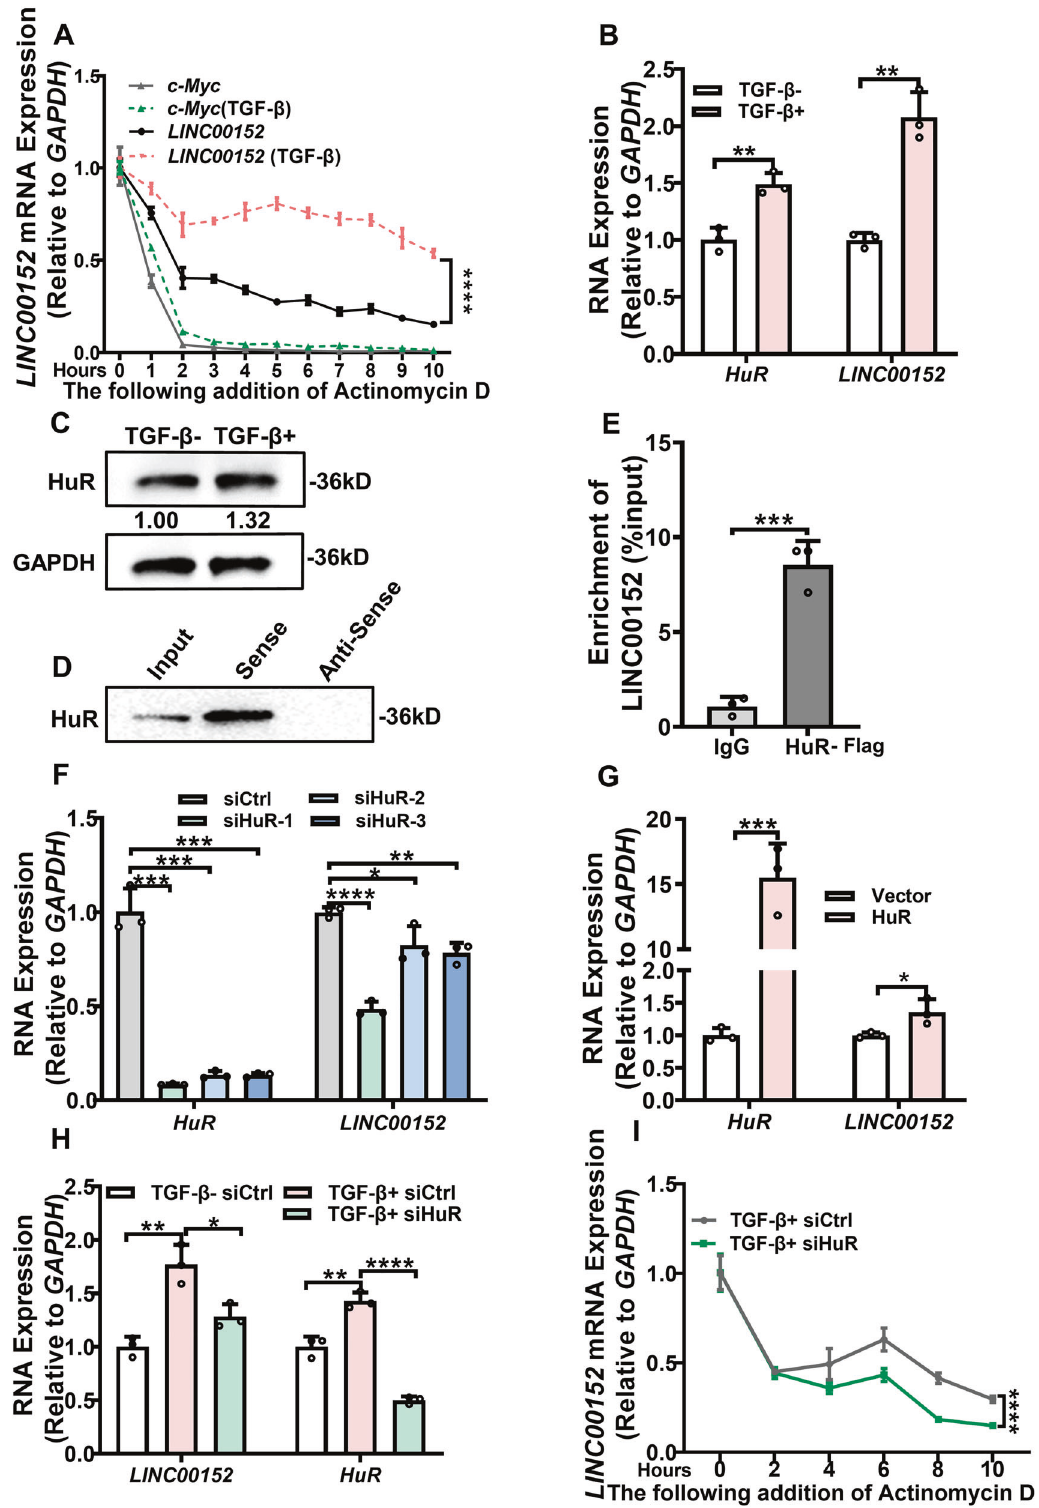
expression changes both at the protein and RNA level in Calu3 cells (Fig. 6B – D). The above experiments suggested that LINC00152 promotes EMT in lung adenocarcinoma cells. In pancreatic cancer, HuR can bind to the SNAI1 mRNA and upregulation its expression to promote metastasis of tumor